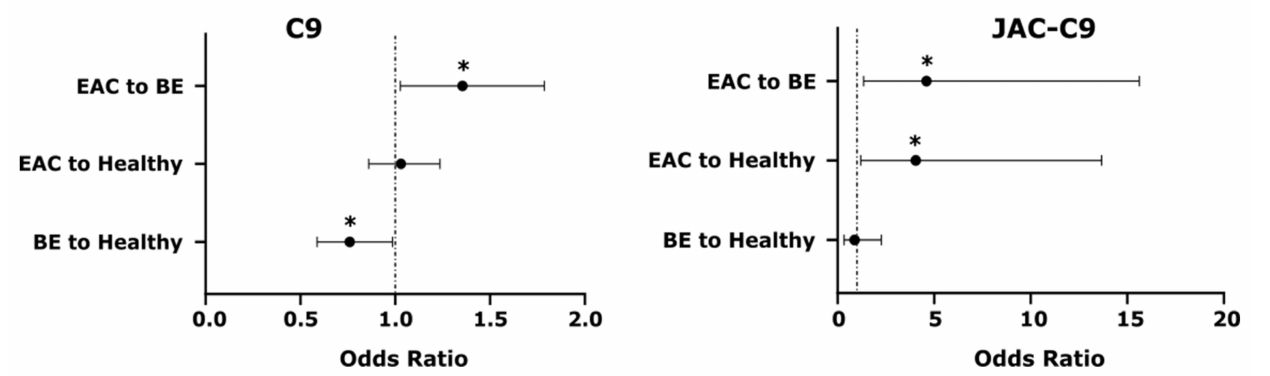
Figure 6. Serum C9 and JAC-C9 show different odds ratios for differentiating between pairs of health conditions in the Biomarker Model. * Wald’s test, p <